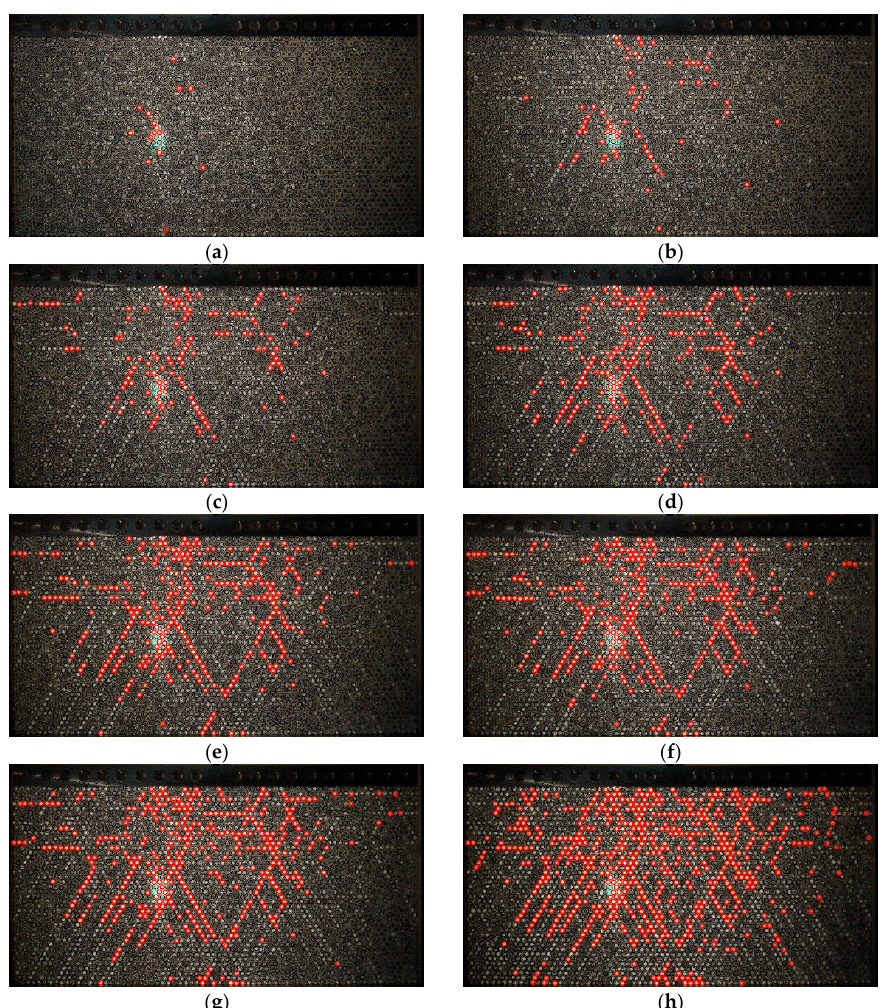
Figure 7. Contact force chains detected by red, green, and blue (RGB) photoelastic digital image analysis during uniaxial loading of a uniform structure: ( a ) before loading; ( b ) F = 500 N; ( c ) F = 1000 N; ( d ) F = 1500 N; ( e ) F = 2000 N;( f ) F = 2500 N; ( g ) F = 3000 N; ( h ) F = 4000 N. Primary contact force chains are marked as red circles, particles with forces < 100 N are shown as black